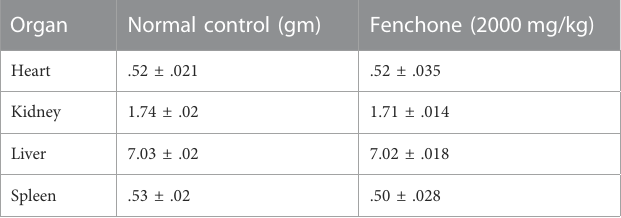
TABLE 3 Effects of F (2000 mg/kg) dose on organ weight in the acute toxicity